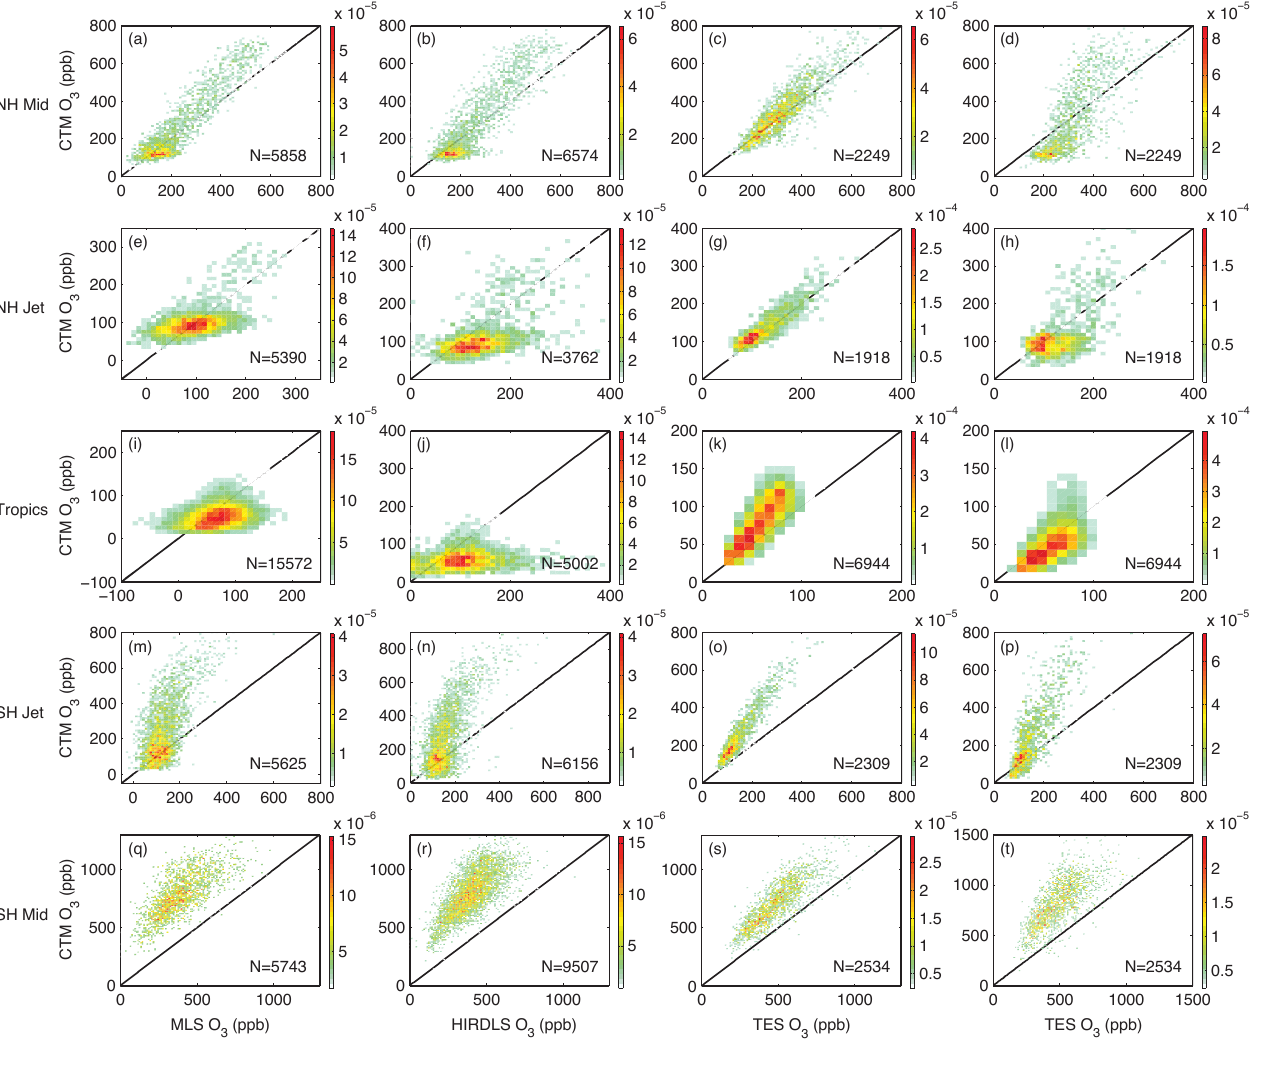
Fig. 6. Same as Fig. 5 for July 2005 at